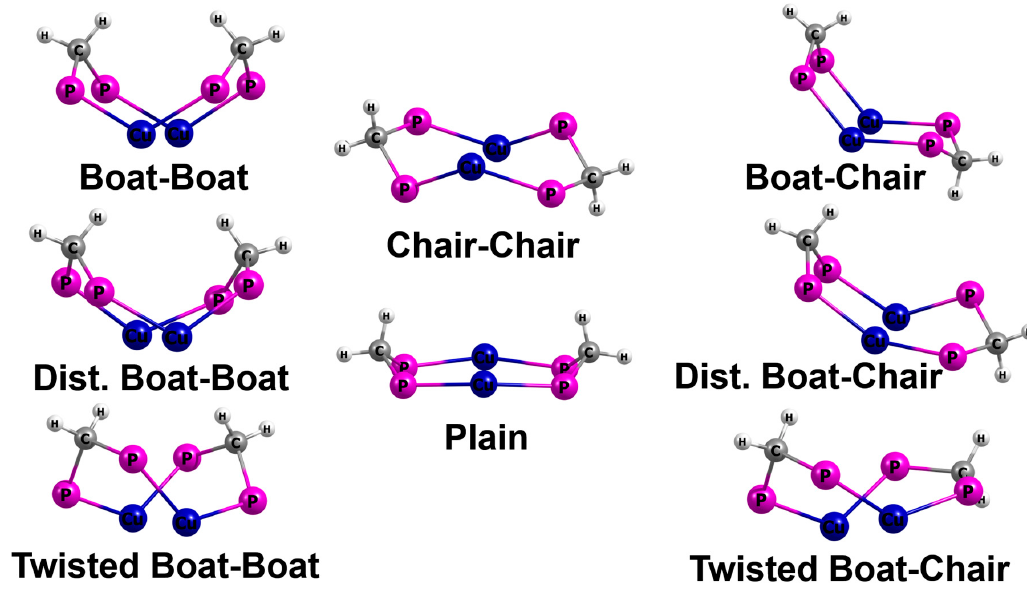
Figure 3. The conformation types found from CCDC search for [( µ 2 -dppm) 2 Cu 2 ] 2+ moieties.